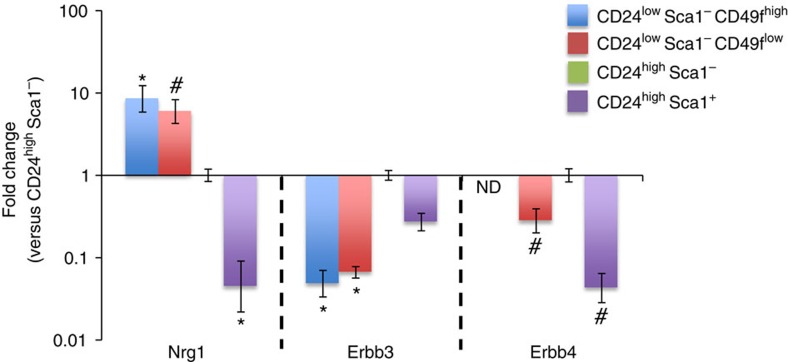
Nrg1 and ErbB are expressed in distinct mammary cell populations.Mammary epithelial cell populations were FACS sorted using a panel of antibodies: CD24low Sca-1− CD49fhigh (stem cell-enriched fraction), CD24low Sca-1− CD49flow (myoepithelial cell population), CD24high Sca-1− (luminal ER-negative cells) and CD24high Sca-1+ (luminal ER-positive cells). Expression of Neuregulin 1, Erbb3 and Erbb4 was evaluated by quantitative RT-PCR (n=3 independent experiments). Fold expression±95% confidence over the comparator population (CD24highSca1−). ND, no expression of Erbb4 detected. *P<0.05; #0.05<P<0.1 (versus CD24high Sca1−), unpaired Student's t-test.